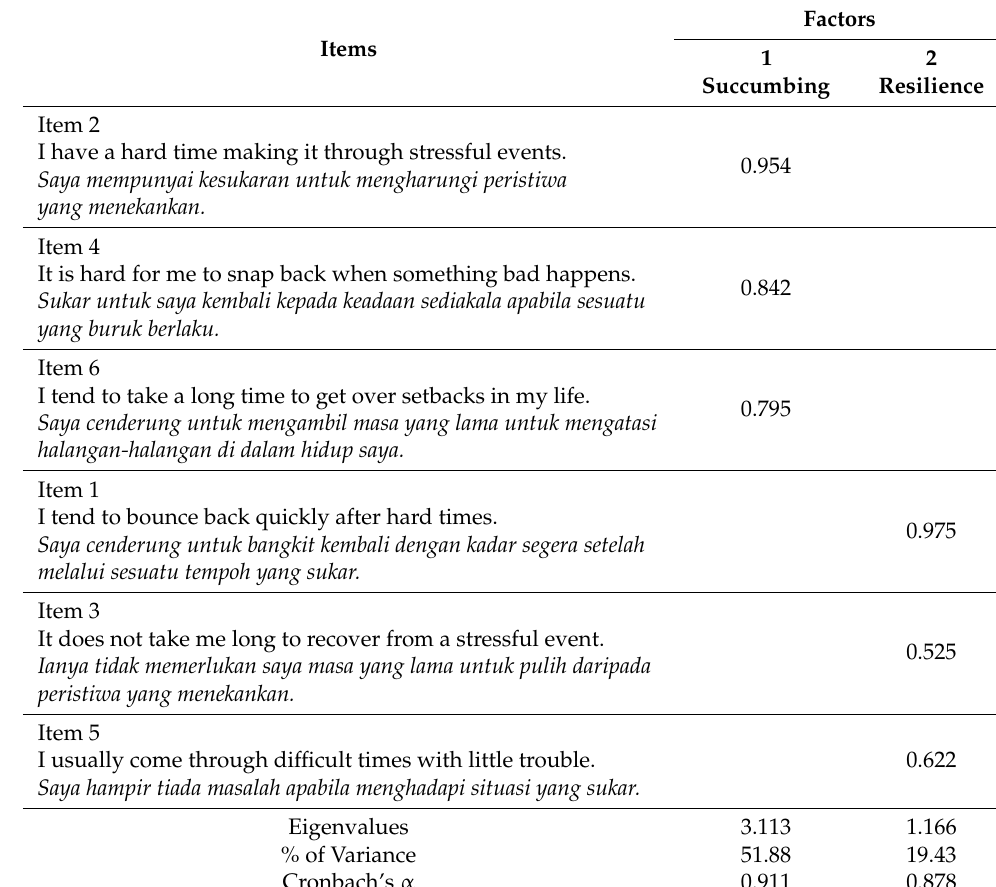
Table 1. Factor analysis of Malay version of the Brief Resilience Scale (BRS-M).